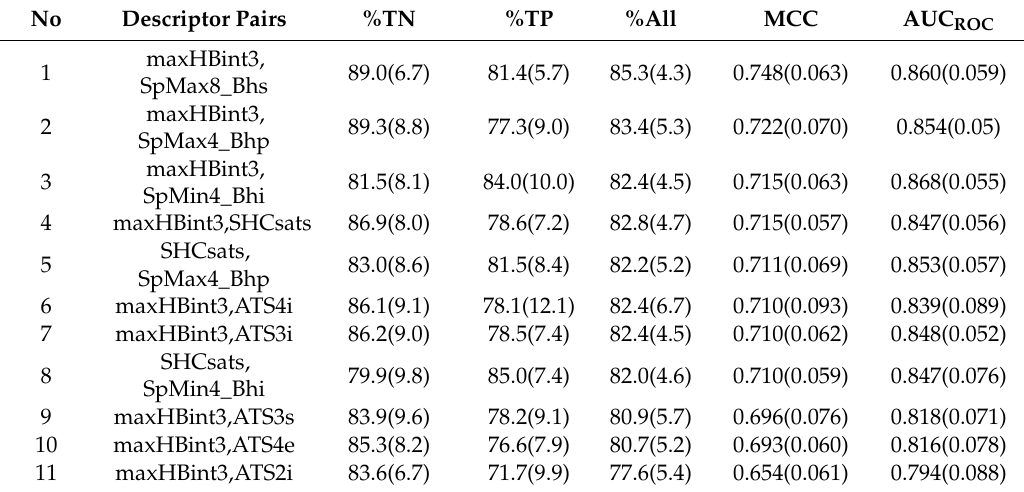
The analysis of orthogonal pairs of descriptors used in models (external test set prediction results). All data are the average values calculated for 50 di ff erent STATISTICA Automated Neural Networks (SANNs). In the parentheses, the standard deviation values were